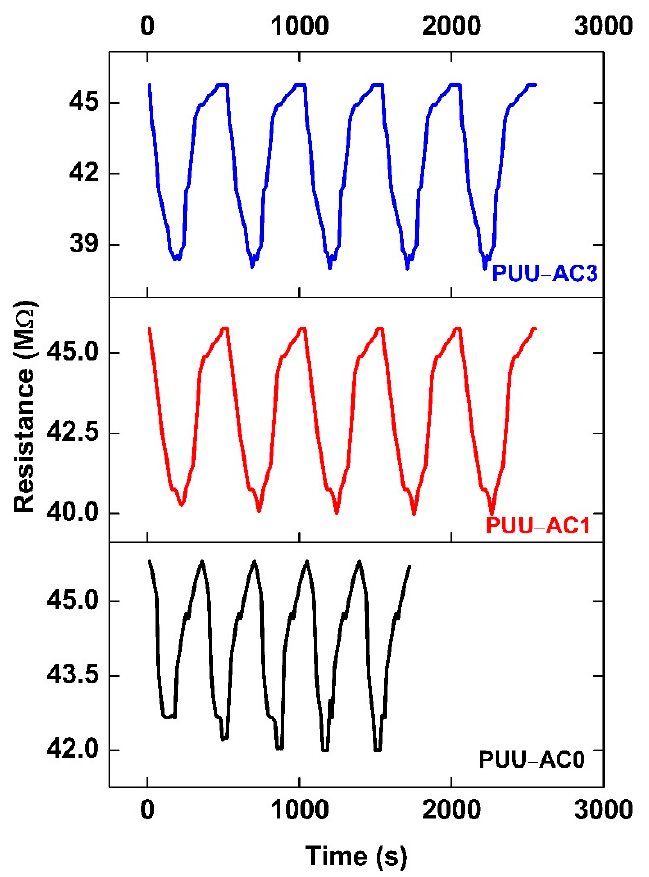
Figure 10. Five consecutive responses of PUU-AC0, PUU-AC1 and PUU-AC3 reported as normal- ized resistance (R a -R g ) to the same concentration of H 2 S (20 ppm), flowed throughout the measuring chamber (1000 sccm) in 60% RH (V = +1 V).